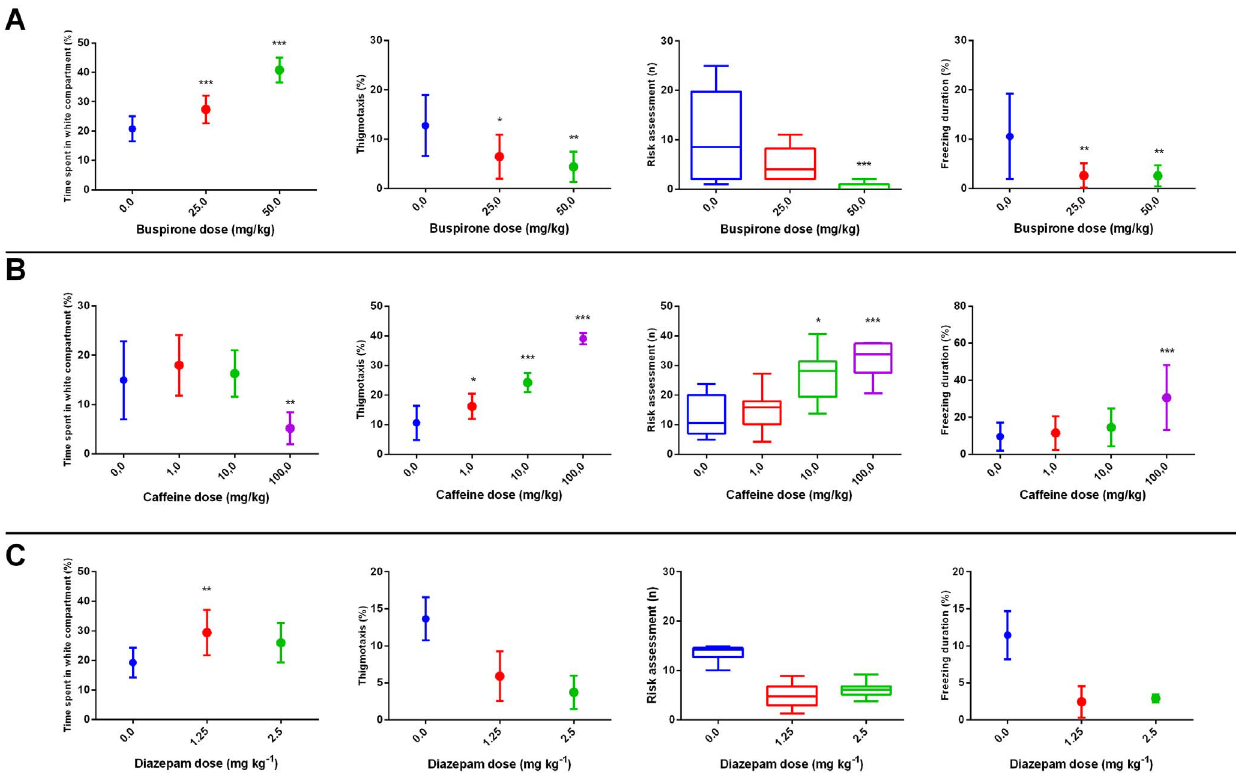
Figure 2. Effects of (A) buspirone, (B) diazepam and (C) caffeine on time on white (upper left), risk assessment (upper right), thigmotaxis (lower left), and freezing (lower right). Bars represent standard error of the mean, and whiskers represent the 2.5 and 97.5 percentile. *, p , 0.05; **, p , 0.01; ***, p , 0.001.